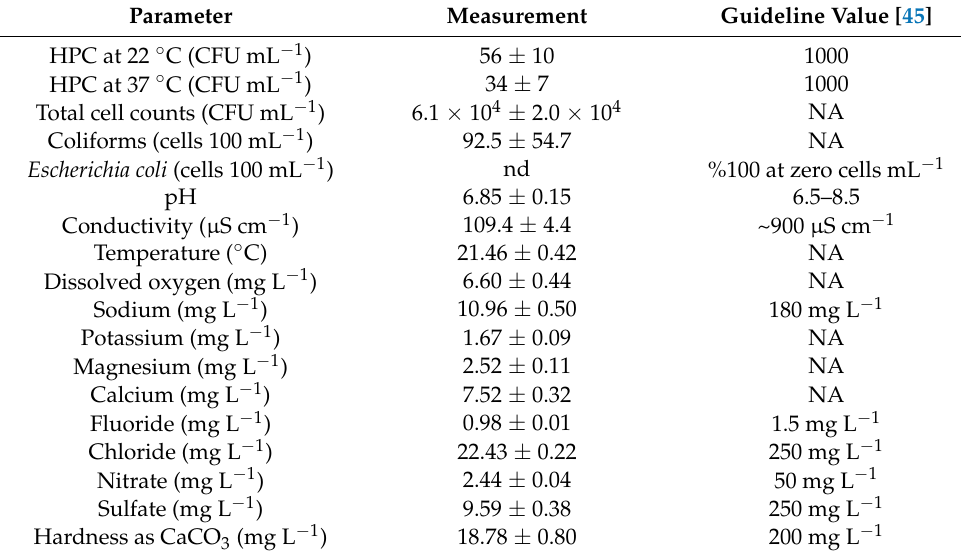
Table 1. Physicochemical and microbiological parameters measured in drinking